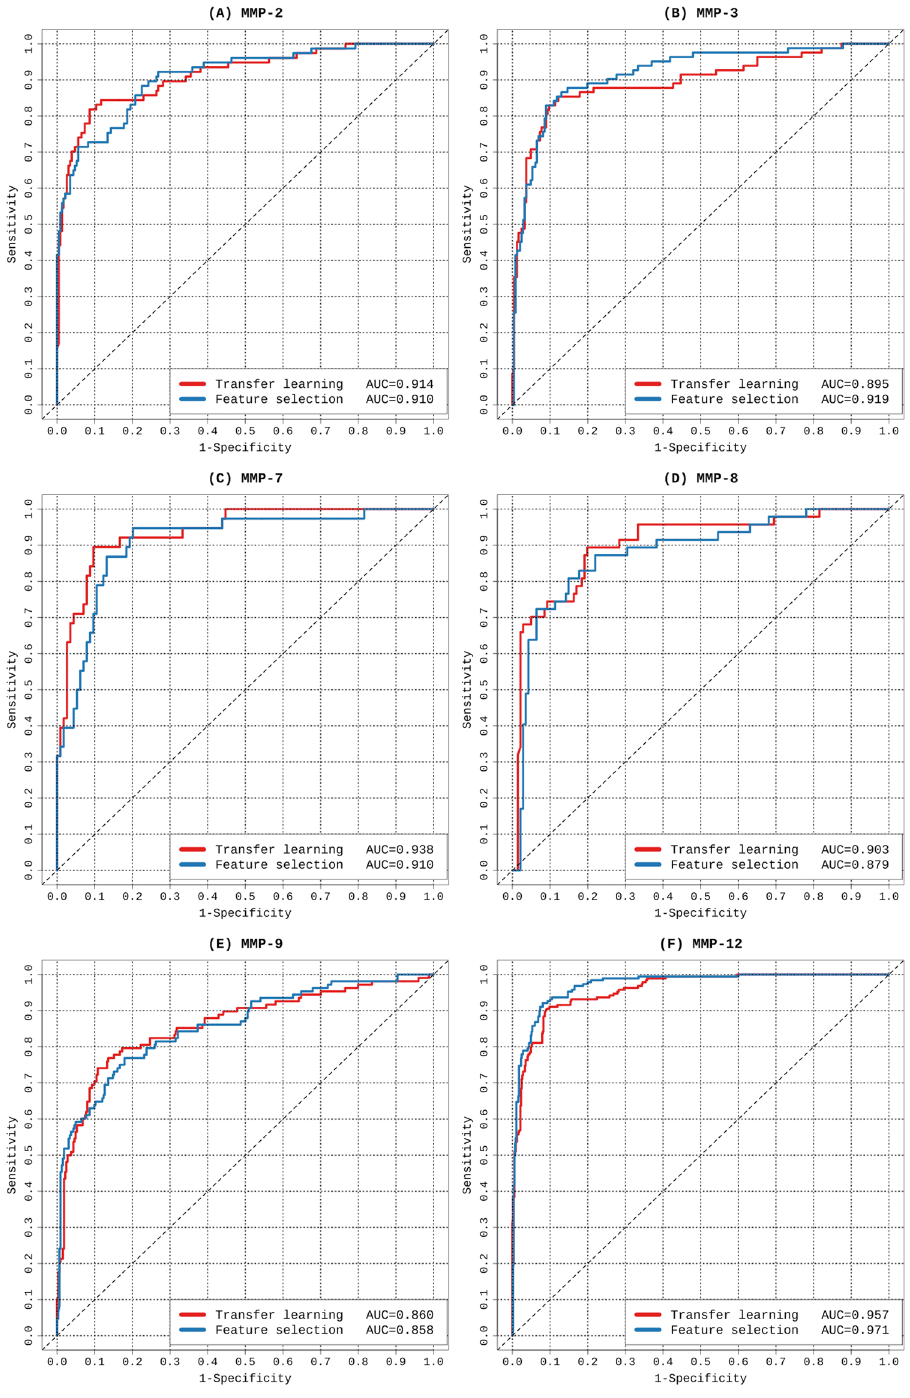
Figure 4. ROC curves of transfer learning and feature selection-based models for the prediction of substrate- cleavage sites for MMP-2, -3, -7, -8, -9, and -12. The results were evaluated based on five-fold cross-validation